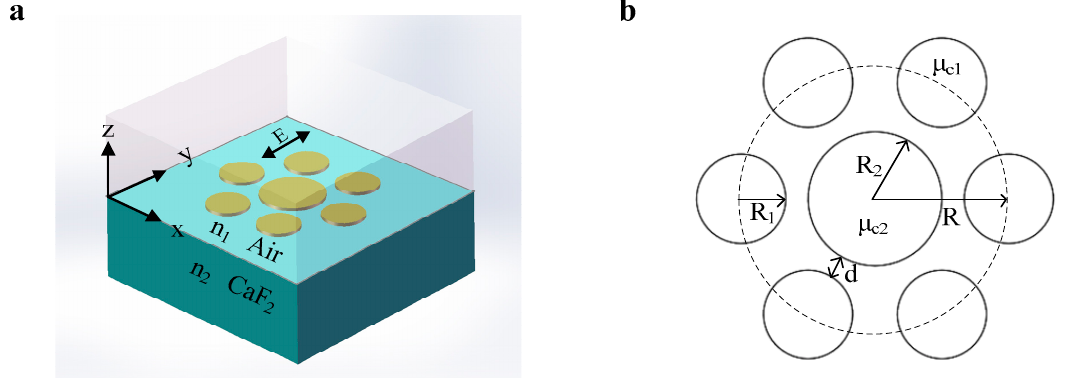
Figure 1. ( a ) The incident light is polarized along the y axis. The graphene oligomer is surrounded by by air with a refractive index n 1 = 1 and placed on calcium fluoride substrate with a refractive index air with a refractive index 𝑛 (cid:2869) = 1 and placed on calcium fluoride substrate with a refractive index 𝑛 (cid:2870) = n 2 = 1.4. ( b ) The top view of the schematic structure of the graphene